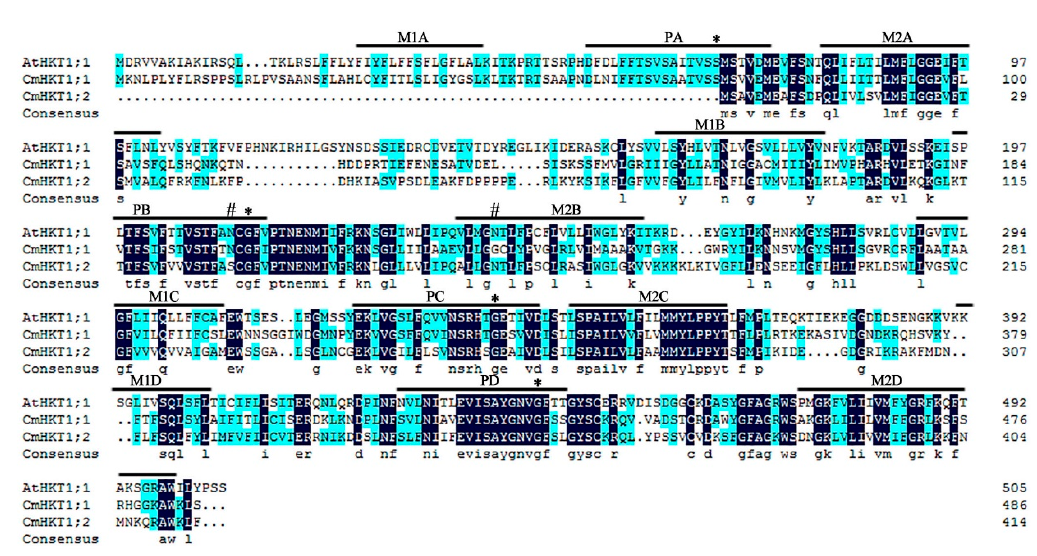
Figure 1. Multiple alignment of CmHKT1;1 and CmHKT1;2 amino acid sequences with Arabidopsis thaliana AtHKT1;1. Identical and similar amino acids are represented by dark blue and light blue, respectively. Sequences were aligned using DNAMAN (Lynnon Biosoft). Positions of the transmembrane and pore segments were predicted according to the model proposed for the topology of the AtHKT1;1 protein, which was based on the four-MPM structural model. The conserved Gly residues in the K + channel selectivity filter GYG of the P-loop-like domains (highlighted by asterisks) determine the K + selectivity of HKTs [5]. The presence of Gly in the PA-loop is conserved in K + -permeable HKTs (class II), whereas the presence of Ser instead of Gly is conserved in Na + -permeable HKTs (class I) [5,7]. “#” defines the positions of Asp residues (D) that are shown to be essential determinants for K + transport activity in TsHKT1;2 [29].